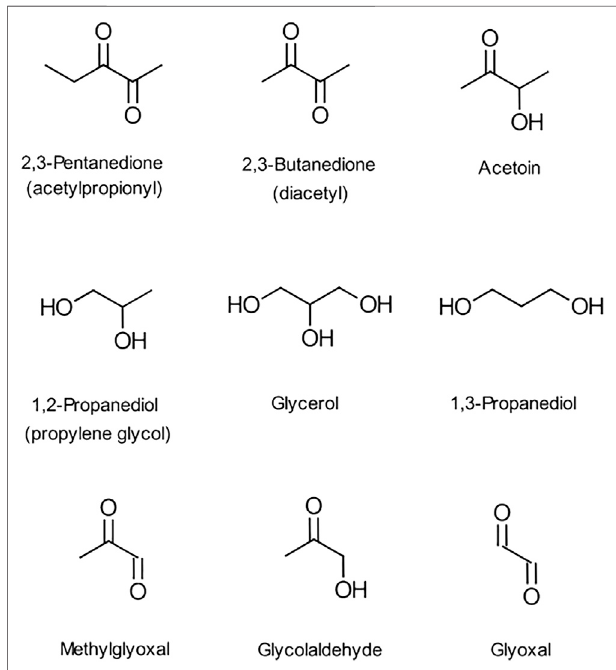
FIGURE 1 | Structures of the ketones, glycols, methylglyoxal, glycolaldehyde and glyoxal.